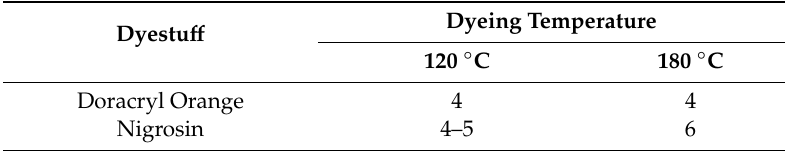
Table 4. Fastness to light of amorphous m-aramid fabrics dyed in EMIM-EtSO 4 with Doracryl Orange and Nigrosin at 120 ◦ C and 180 ◦ C, respectively.